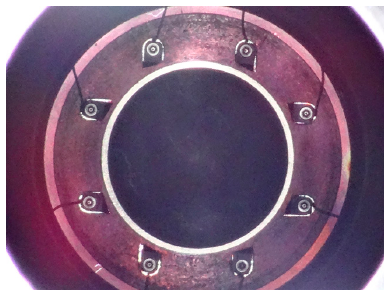
Figure 2. Picture of the fixed muon target, taken from 12 m upstream along the proton beamline (before upgrading to the current rotating target).